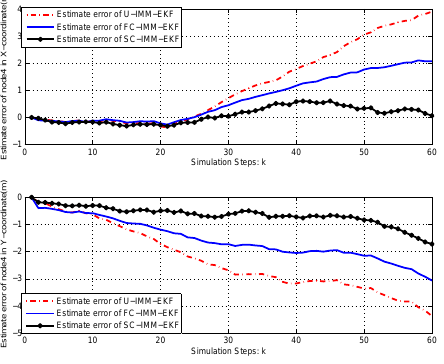
Figure 12. Estimate error of node 4.